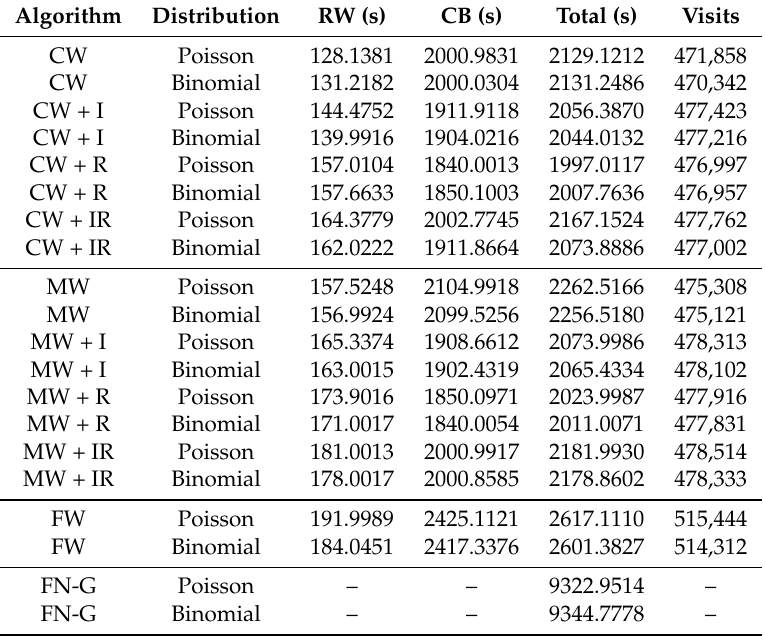
Table 3. Performance in terms of time (sec) and vertex